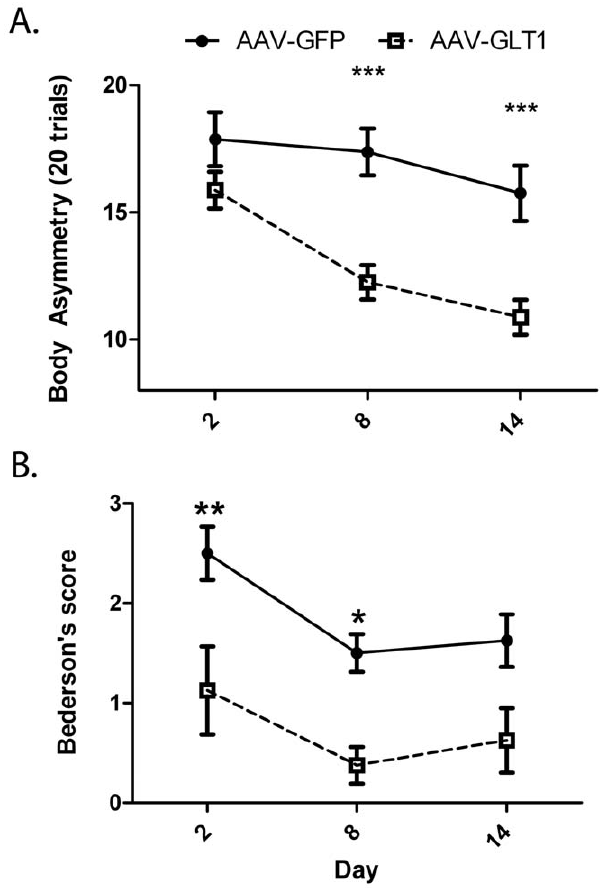
Figure 4. AAV-GLT1 promotes behavioral recovery after cerebral ischemia. Behavioral tests were carried out at 2, 8 and 14 days after the MCAo and analyzed with 2-way ANOVA. AAV-GLT1 injection significantly reduced body asymmetry in an elevated body swing test (A) and neurological abnormality scores in Bederson’s test (B). *p , 0.05, **p , 0.01, ***p , 0.001; Bonferroni test.